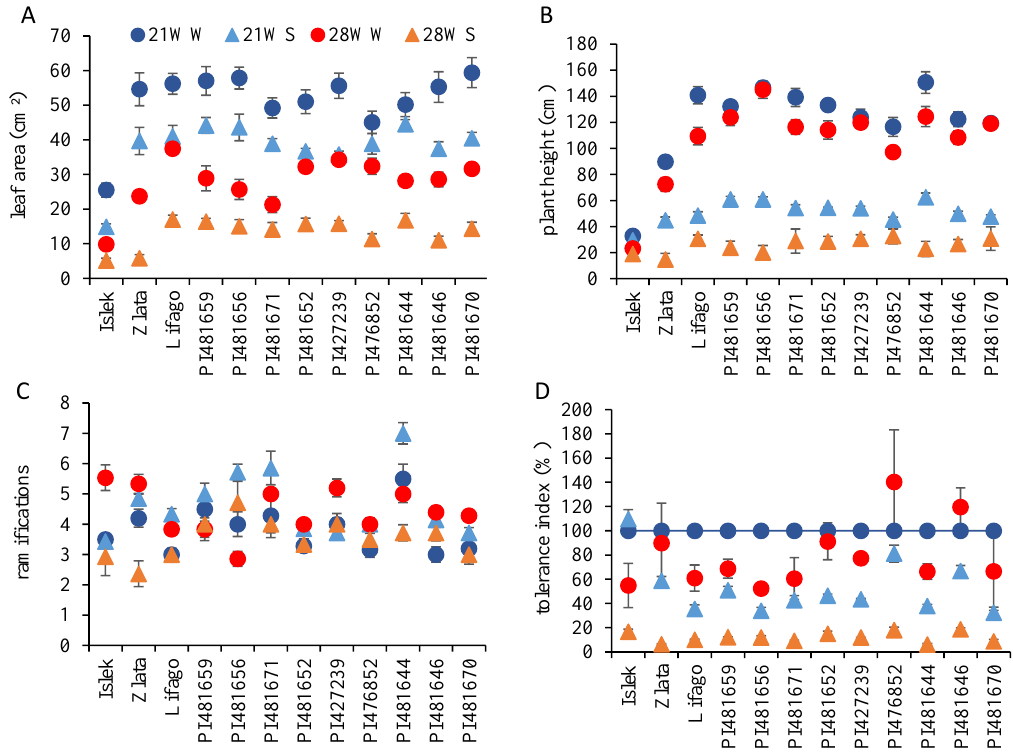
Figure 3. Vegetative growth parameters of F. tataricum varieties subjected to two temperatures (21 °C vs. 28 °C) and water supply conditions (well-watered vs. water-stressed). ( A ) Leaf area, ( B ) plant height, ( C ) number of ramifications per plant, and ( D ) tolerance index. 21WW: 21 °C well-watered, 21WS: 21 °C water stress, 28WW: 28 °C well-watered, 28WS: 28 °C water stress.